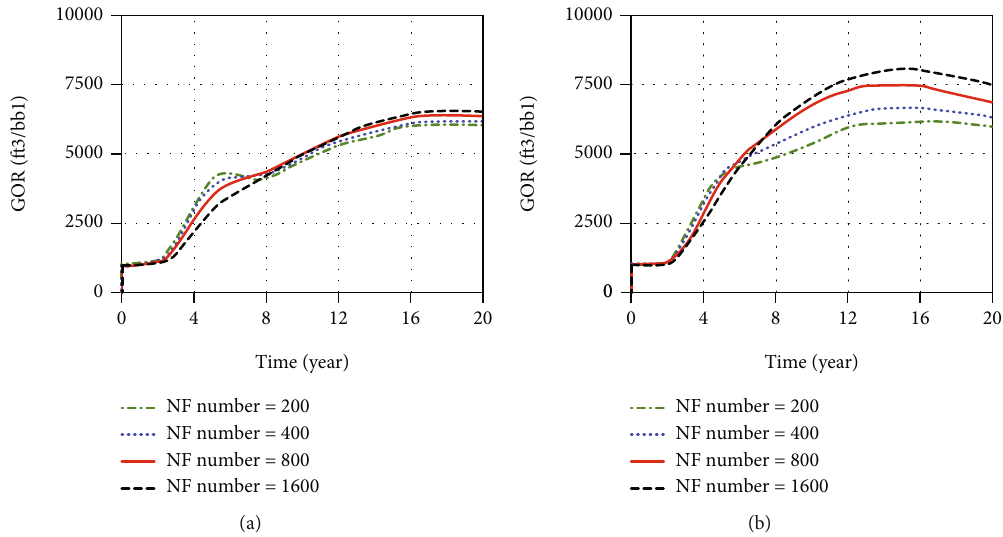
Figure 15: Comparison of 20-year GOR prediction with di ff erent numbers of natural fractures under 2 di ff erent settings of natural fracture conductivity (NFC): (a) low conductivity at 0.1 md-ft and (b) high conductivity at